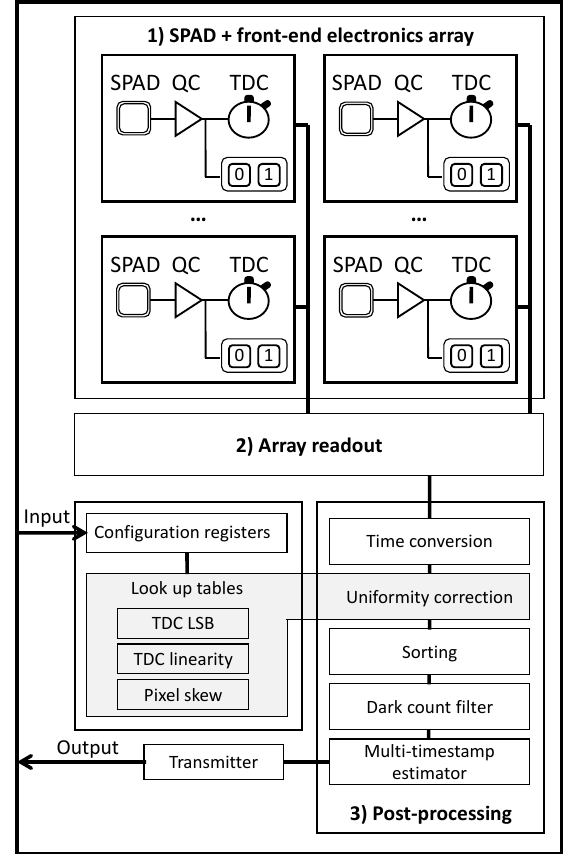
Figure 13. Block diagram of a 3D PDC dedicated to PET. (1) The SPAD, QC, TDC and counter array; (2) An array readout to send the information to the digital signal processing; (3) The digital signal processing with TDC uniformity correction, timestamp sorting and filtering and a time estimator based on multiple